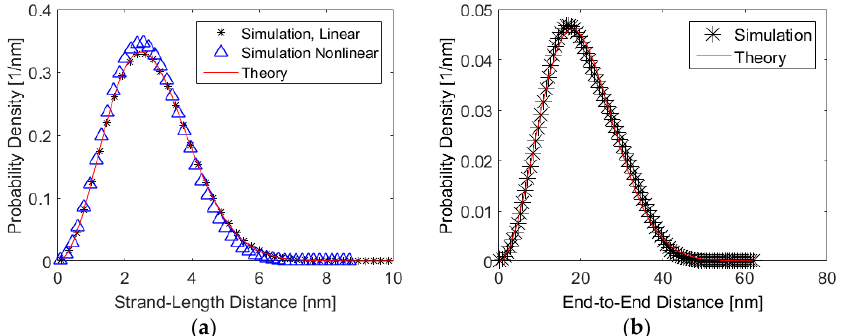
Figure 4. Strand length ( a ) and end-to-end distance ( b ) distributions for a crosslinked polymer network created by random crosslinking. More details are provided in the main text.